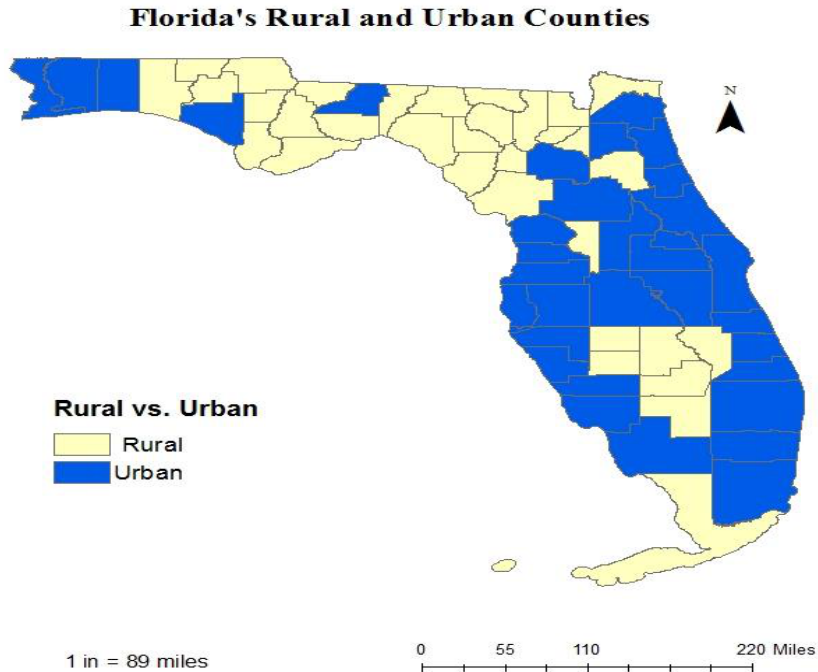
Figure 1. Urban and rural counties based on U.S. census.